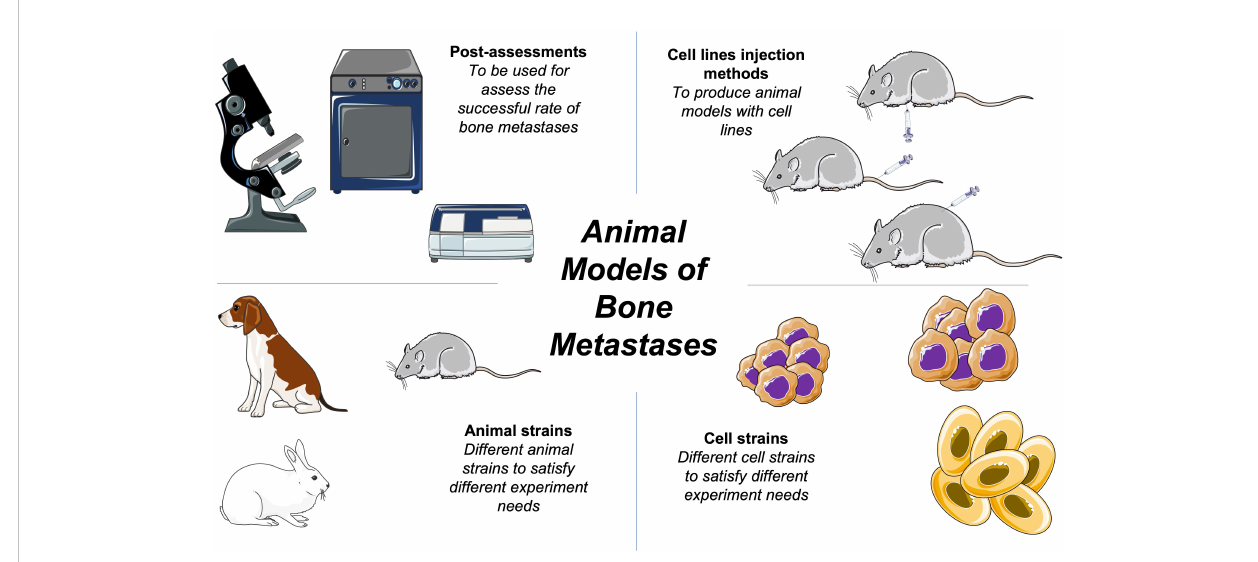
FIGURE 1 Schematic of basic bone metastases animal models